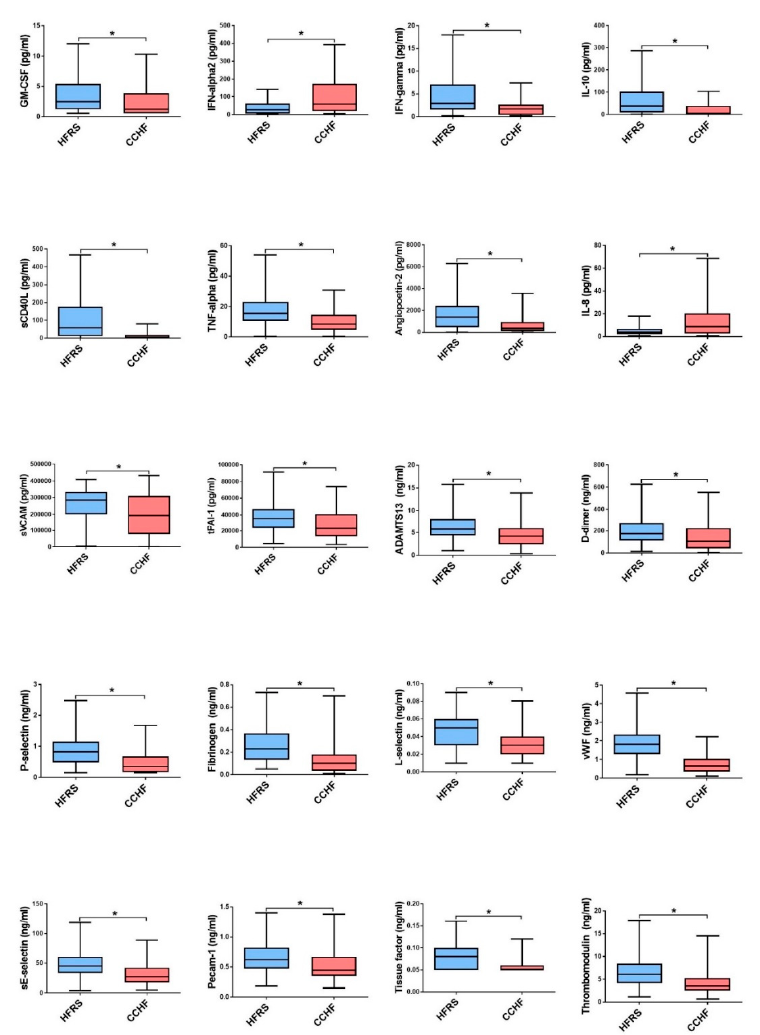
Figure 5. The cytokine and chemokine concentrations with significant differences between in HFRS ( n = 100) and CCHF ( n = 70) patients. The statistically significant differences are marked with * ( p < 0.05). ns = not statistically significant. The boxes represents medians with interquartile ranges; the whiskers depict minimum and maximum values (range). Identified outliers are not included in the figures above: GM-CSF (HFRS n = 8; CCHF n = 5), IFN- α 2 (HFRS n = 4; CCHF n = 5), IFN- γ (HFRS n = 8; CCHF n = 1), IL-10 (HFRS n = 8; CCHF n = 5), TNF- α (HFRS n = 6; CCHF n = 3), Angiopoetin-2 (HFRS n = 9; CCHF n = 1), D-dimer (HFRS n = 1; CCHF n = 4), P-selectin (HFRS n = 4; CCHF n = 7), pCAM-1 (HFRS n = 4; CCHF n = 2), TF (HFRS n = 6; CCHF n = 8), TM (HFRS n = 2; CCHF n =